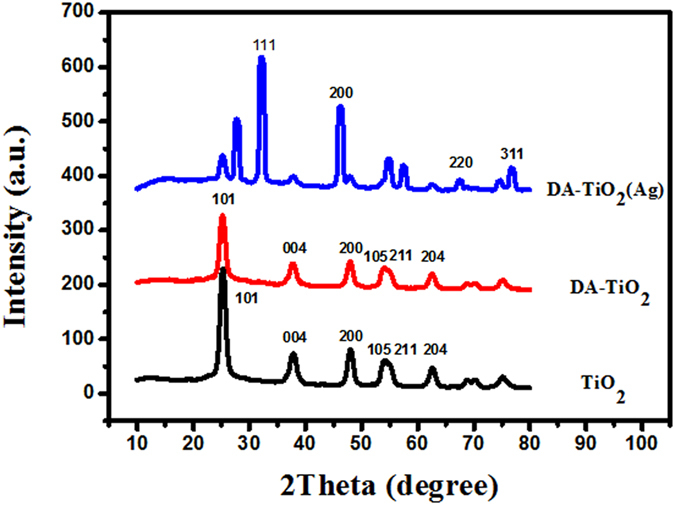
XRD patterns of TiO2, DA-TiO2, and DA-TiO2 (Ag) composites, where the diffraction peaks of TiO2 for TiO2 and DA-TiO2, and those of Ag0 for DA-TiO2 (Ag) composites are indicated.